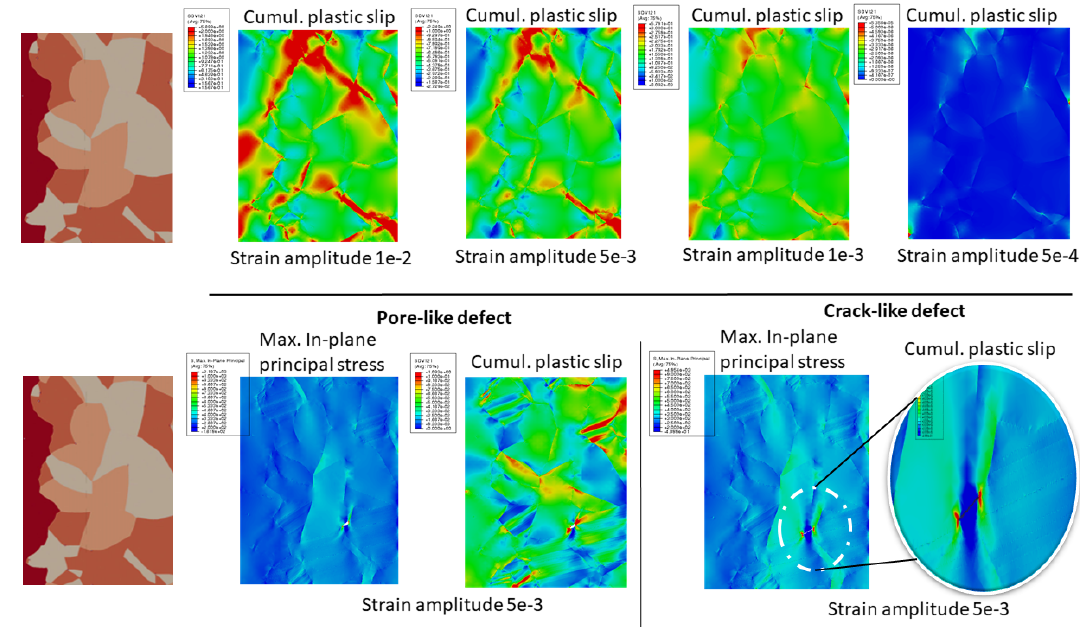
Figure 7. Cyclic loading of an equiaxed Ti-6-4 structure at different strain amplitudes without defects ( top row ) and with two different types of defects ( bottom row